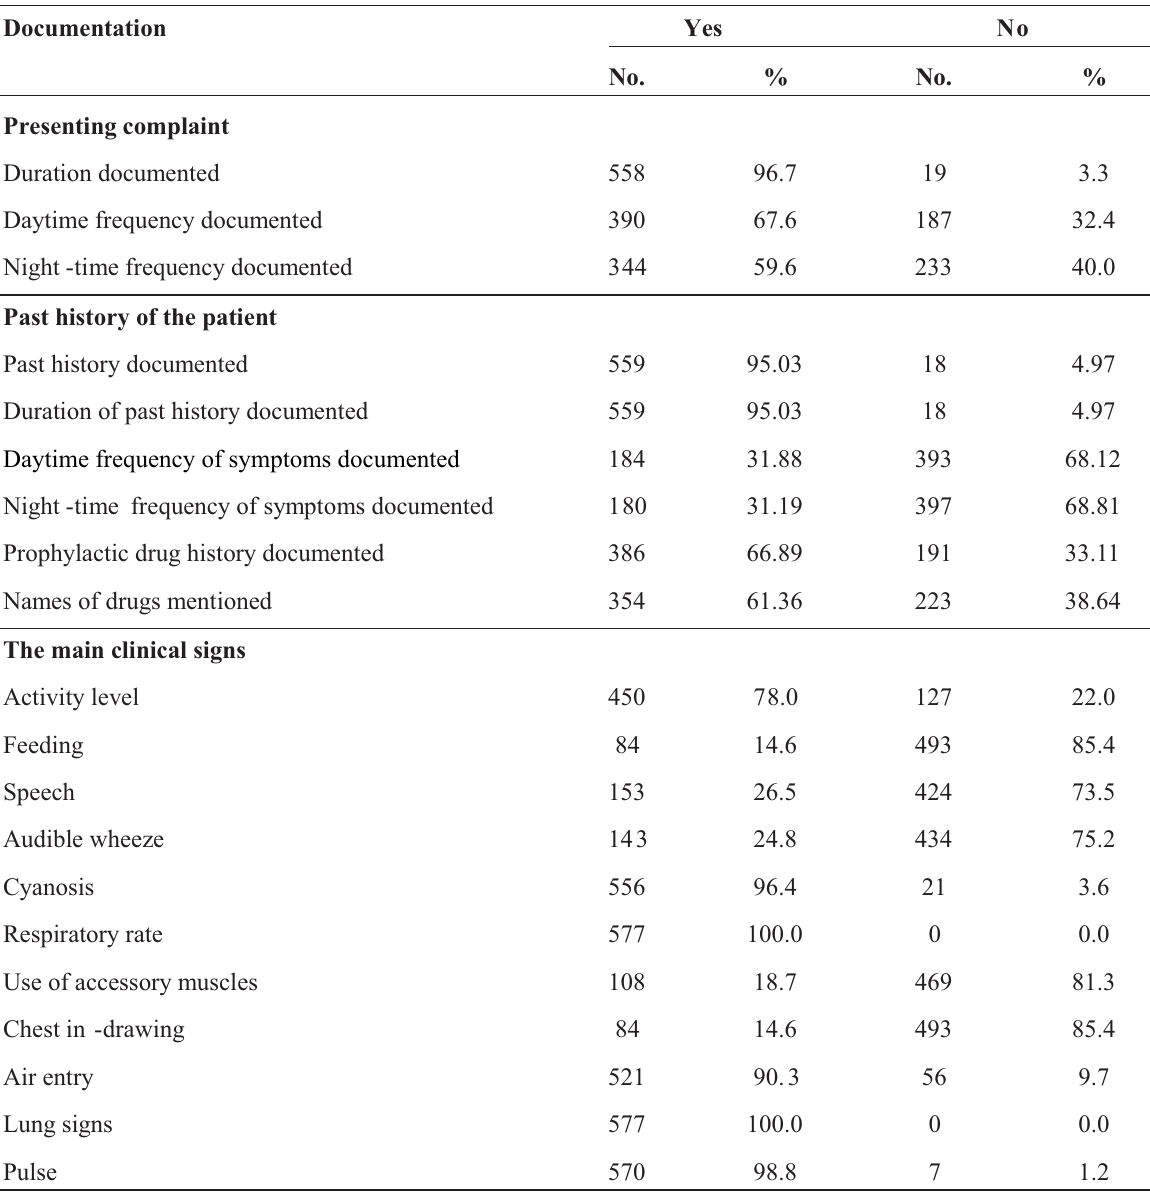
Table 2: Distribution of the study population by completeness of information on BHT (N=577)